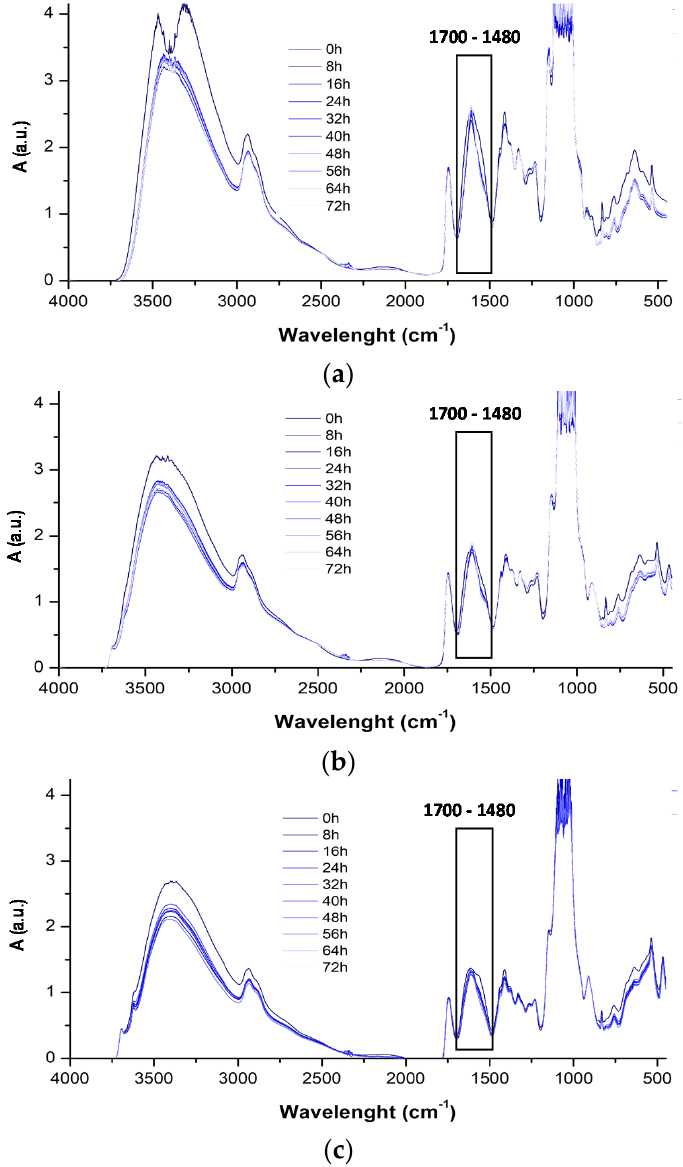
Figure 5. FTIR spectra at different exposure time of ( a ) CS:PC, ( b ) CS:PC/CA and ( c ) CS:PC/HNT films.